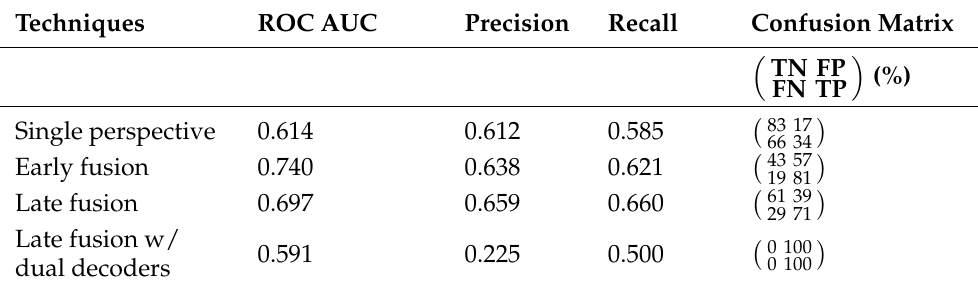
Table 3. Results for different fusion techniques on our multi-perspective dices dataset with a denoising autoencoder in the pre-training stage of Deep SVDD [6]. True positive samples (TP) are anomalous, etc. For the Late fusion technique, it is convenient to apply Deep SVDD to single images of the dices dataset—without taking into account the different perspectives. The result for this “single-perspective” Deep SVDD is given in the first row.